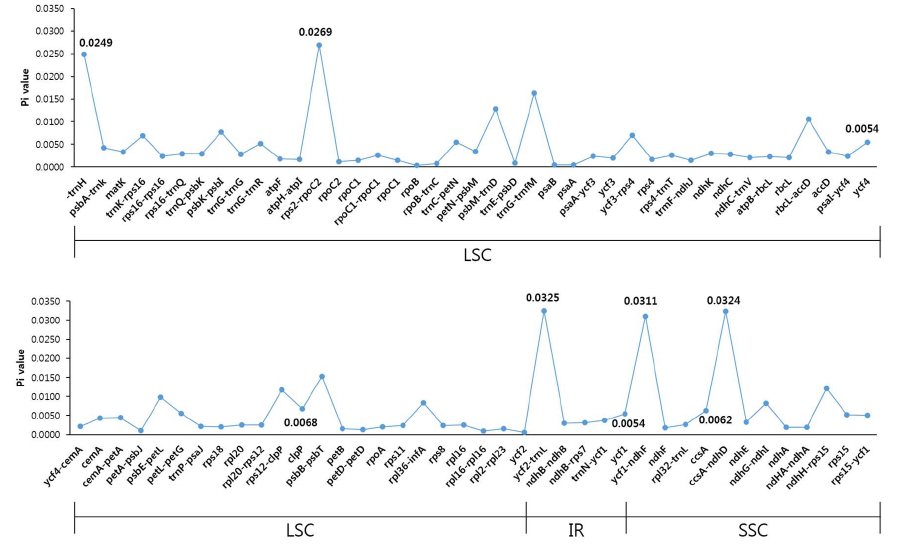
Figure 4. The comparison of nucleotide diversity (Pi) between the chloroplast genomes of D. asper and D. japonicus .